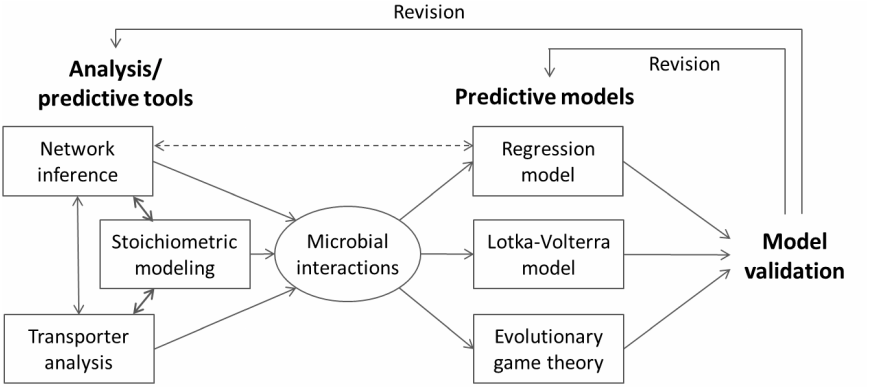
Figure 9. The use of network analysis tools for the construction of predictive models and the feedback loop for the subsequent revision through model validation processes. Solid arrows represent information flows. The dotted arrow indicates that nonlinear regression can be used as a tool for network